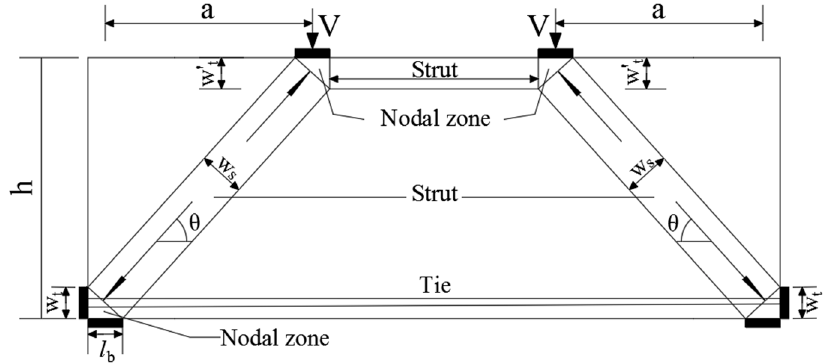
Figure 22. Simplified calculation of strut-and-tie model.